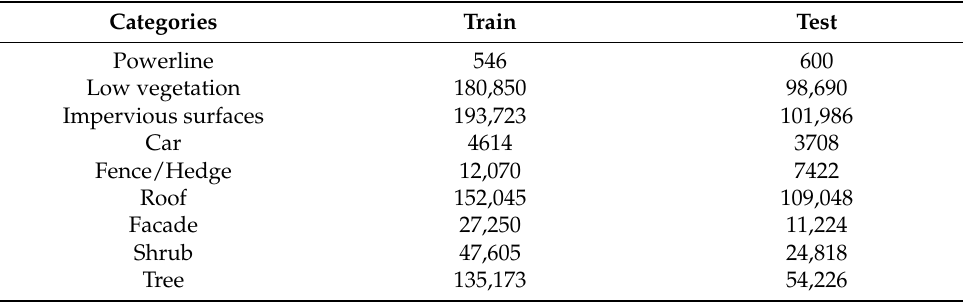
Figure 5. Vaihingen (Germany) urban 3D semantic dataset. Table 1. Number of points in each object category of the training and test datasets.